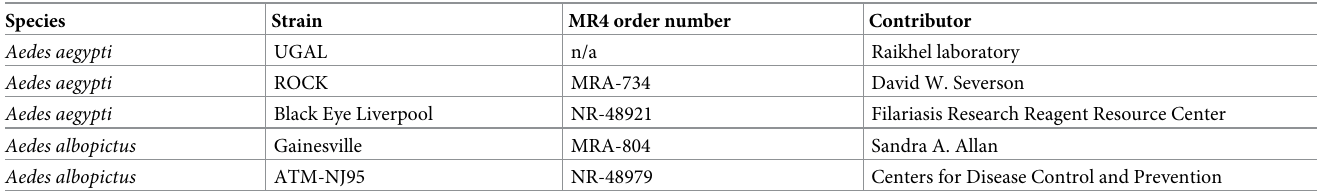
Table 1. Summary of mosquito strains and species used in this